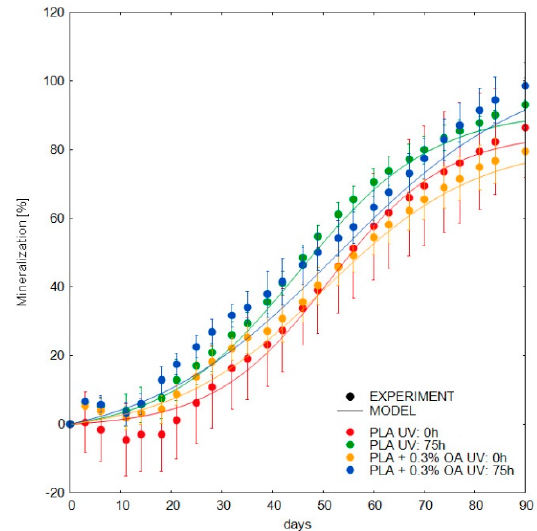
Figure 7. Biodegradation of PLA materials in compost at 58 ◦